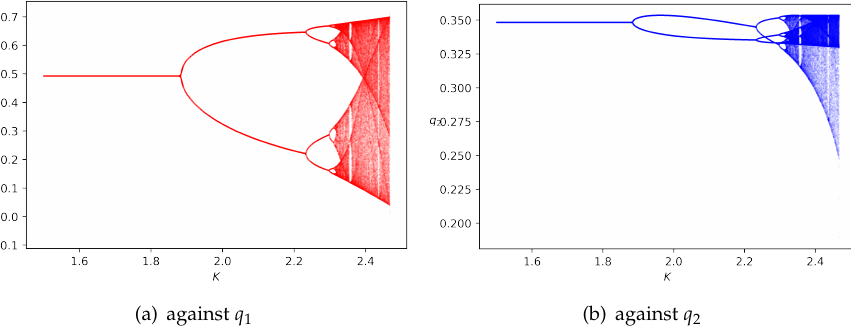
Figure 3. The bifurcation diagrams of the iteration map (3) with respect to K if fixing the parameters c 1 = 0.5, c 2 = 1.0 and setting the initial state as ( x ( 0 ) , y ( 0 )) = ( 0.5,0.5 ) . The bifurcation diagrams against q 1 is given in ( a ), and that against q 2 is given in ( b ).